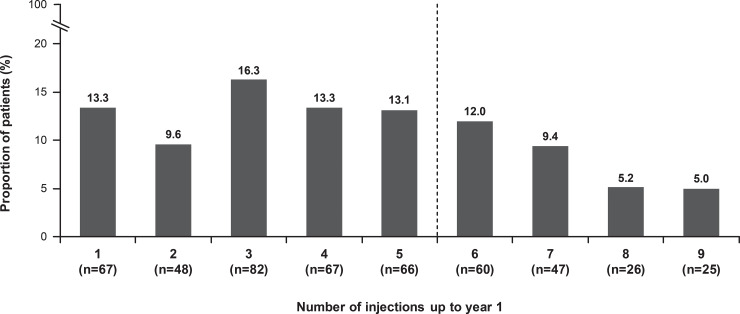
Frequency of injections over 12 months (N = 502, safety set).The safety set consisted of patients in the enrolled set who were treated with at least 1 dose of ranibizumab during this study or prior to start of study and had at least 1 safety assessment after the first treatment. 1.4% (n = 7), 1.0% (n = 5), and 0.4% (n = 2) of patients received 10, 11, and 12 injections respectively. n = number of evaluable patients with baseline and year 1 data. For treatment-naïve eyes, the date of first on-study injection with ranibizumab was considered the baseline date. For the 1-year time period, all patients with non-missing baseline VA and year 1 VA performed anywhere between Day 319 and Day 409 but who had been in the study for at least 365 days from baseline to last follow-up date were included in the analysis. VA, visual acuity.